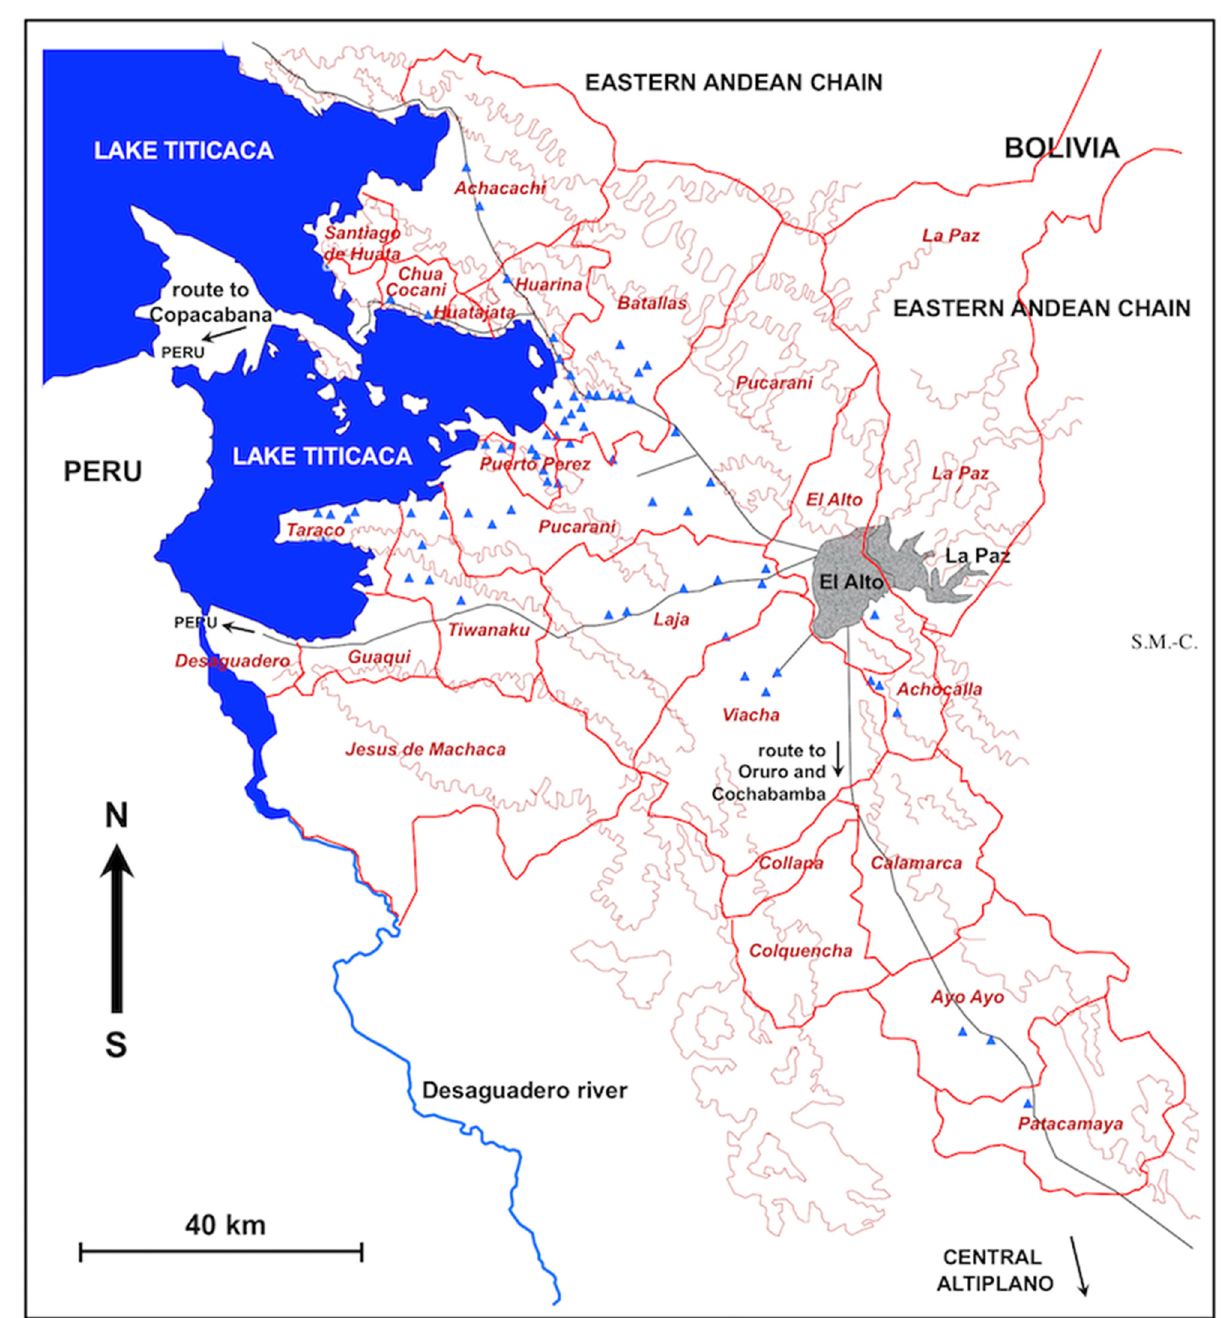
Figure 2. Map of the Northern Bolivian Altiplano showing the distribution of fascioliasis transmission foci according to municipalities affected by the disease and those in the direct neighbourhood. Blue triangles = freshwater collections inhabited by Galba truncatula snail vectors; red lines = boundaries of municipalities. Original S.